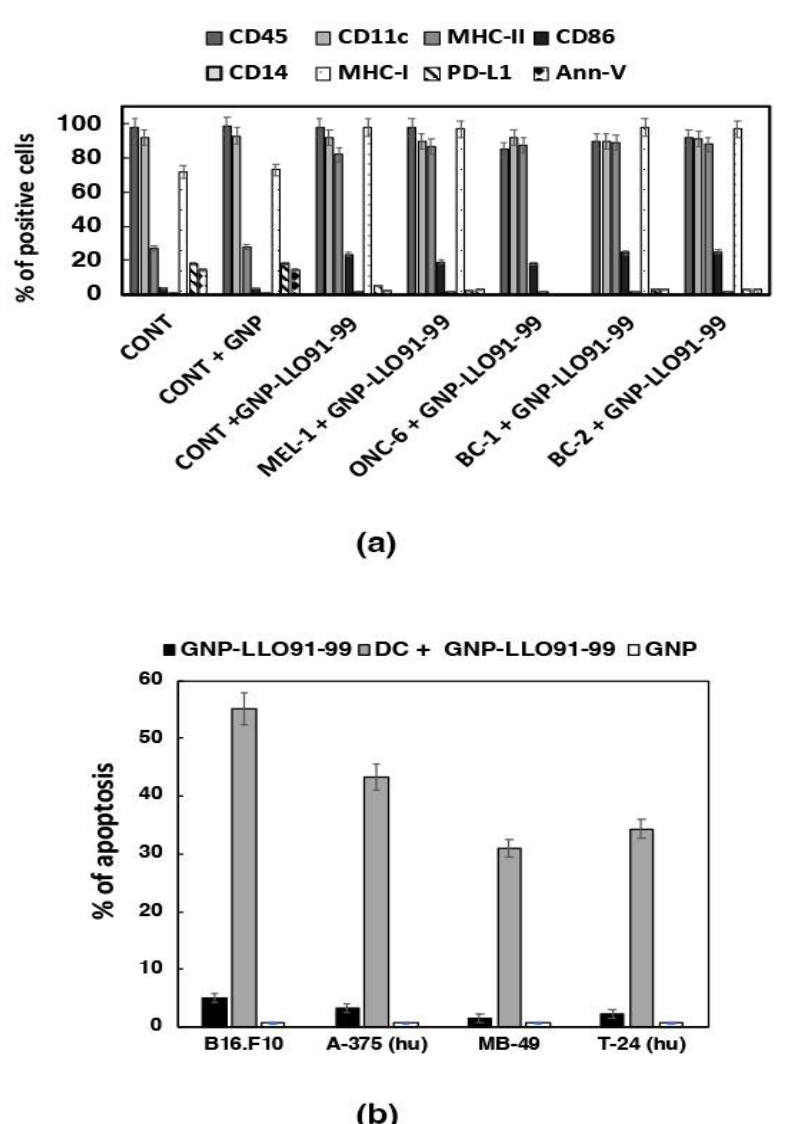
Figure 2. Adjuvant effects and immunogenic apoptosis abilities of GNP-LLO 91–99 nanovaccines. ( a ) Ex vivo differentiated MoDCs from patients (melanoma: MEL-1, MEL-2, bladder cancer: BC-1, BC- 2) or healthy donors (CONT) with the phenotype CD45 + CD11c + CD14 - were incubated or not with